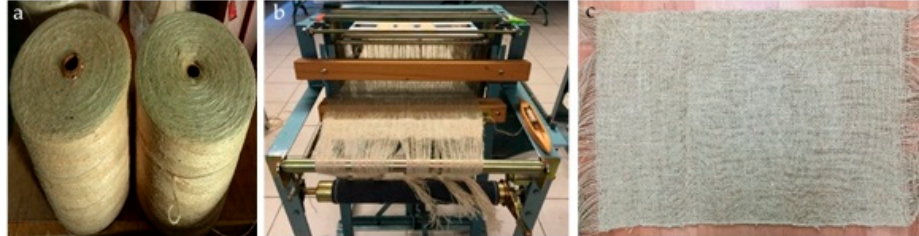
Figure 1. ( a ) Kenaf yarn with 500tex linear density wound on cylindrical bobbins; ( b ) hand loom used in the weaving process; ( c ) kenaf woven fabric.